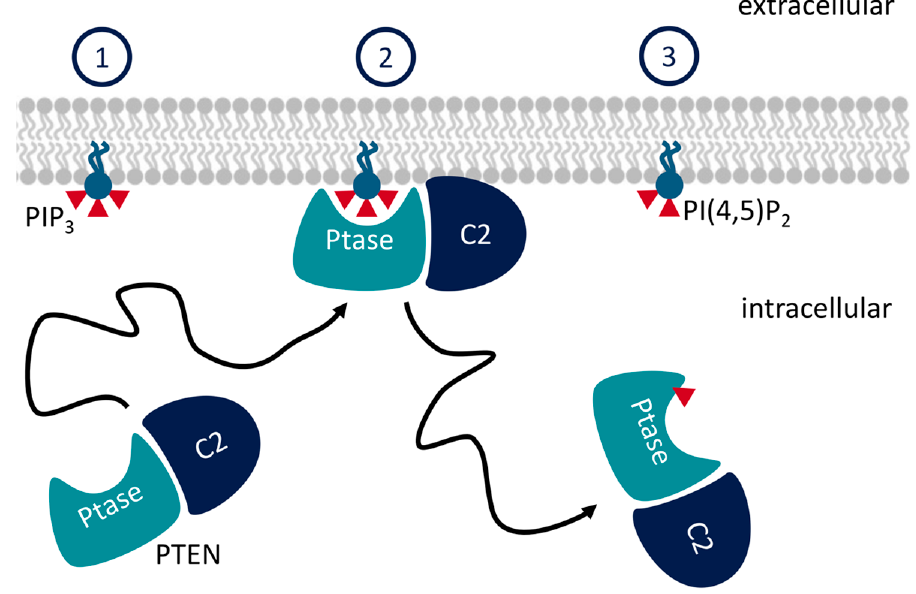
Figure 1. The function of PTEN: PTEN binds the inner leaflet of plasma membrane and dephosphorylates PI(3,4,5)P 3 to form PI(4,5)P 2 . SHIP2 works similarly, but the product is instead PI(3,4)P 2 . Adapted from Ref. [7].